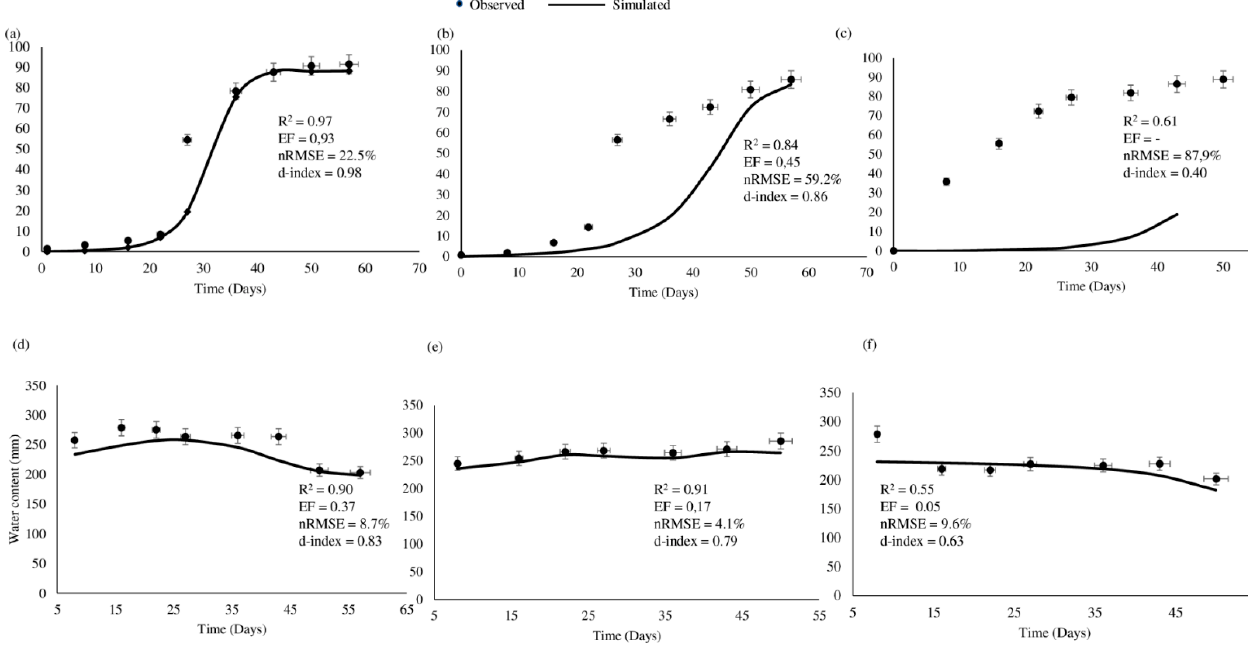
Figure 6. Canopy cover ( CC ) for ( a ) 100% ET c , ( b ) 75% ET c , and ( c ) 55% ET c and soil water content (SWC) for ( d ) 100% ET c , ( e ) 75% ET c , and ( f ) 55% ET c irrigation regimes during validation.